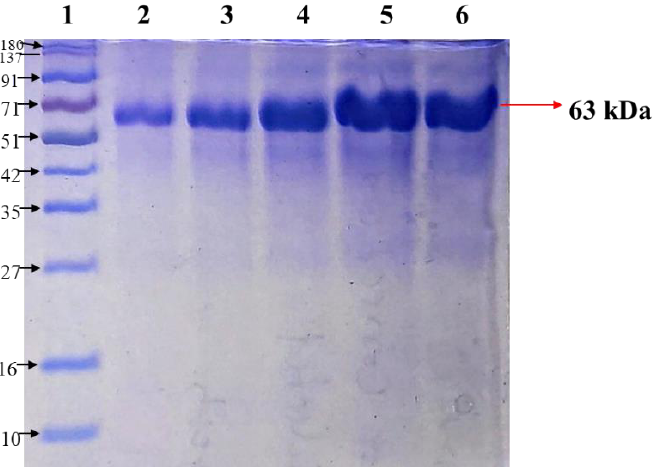
Figure 2. SDS-PAGE profile indicating 63 kDa purified form of tyrosinase, with lane 1 showing protein marker and lanes 2–6 depicting the purified tyrosinase loaded in gradient (lanes 5, 6 represent highest concentration of protein). Table 1. Purification summary of tyrosinase.